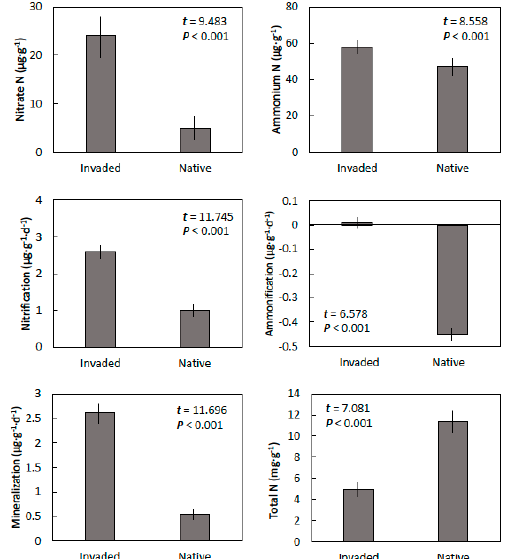
Figure 2. The nitrogen properties of Guam cobbly clay soils within invaded mature stands of Leucaena leucocephala and in adjacent native forest in central Guam. Means ± SE, n = 6.